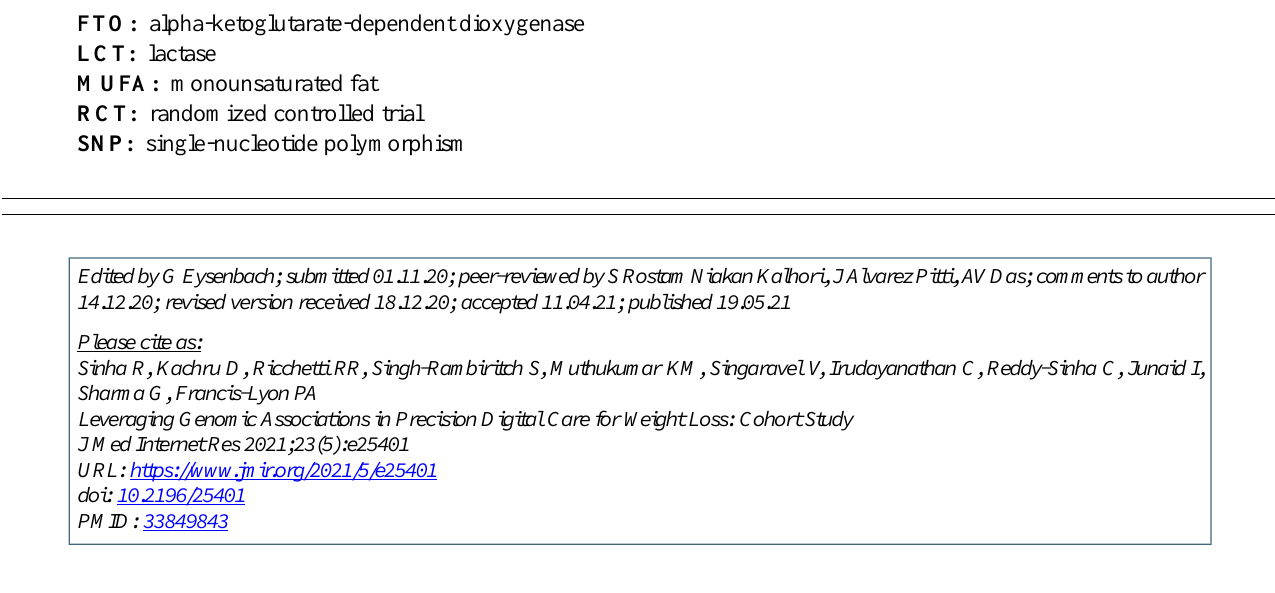
Abbreviations FTO: alpha-ketoglutarate-dependent